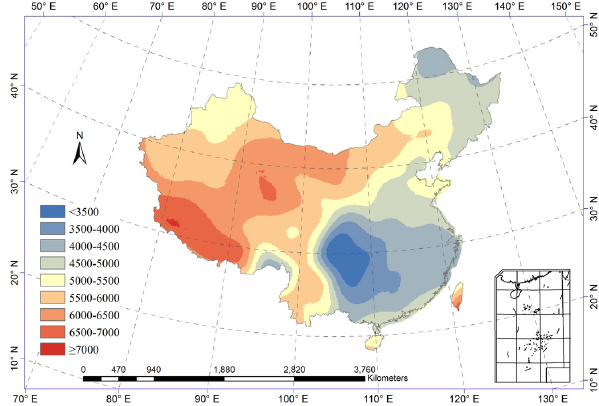
Fig. 7. Spatial distribution of perennial average of annual global radiation in China during 1981–2010 (Unit: MJm − 2 yr − 1 ) .